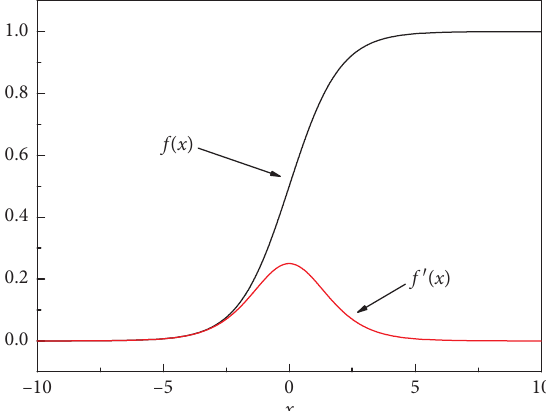
Figure 1: Polyline slip surface.